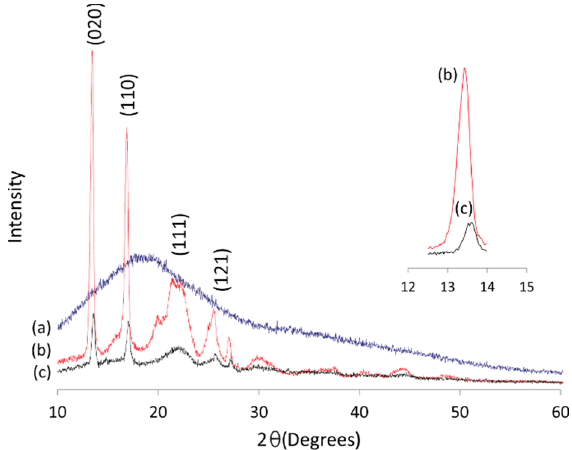
Figure 8. XRD diffractogram of PullN 3 ( a ) PHBHV-alkyne ( b ) and grafted Pull- g -PHBHV copolymer ( c ).